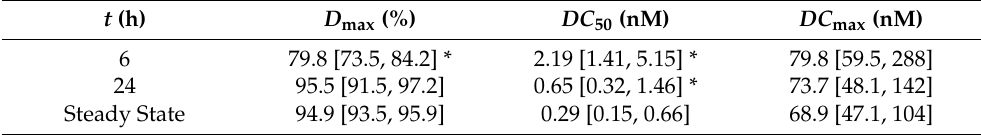
Table 1. The descriptive parameters corresponding to the two incubation times are stated together with their steady-state counterparts. Parameter values for 6 h and 24 h incubation were obtained by fitting two individual hook models (Equation (12)) to the data. Fitting the extended hook model (Equation (14)) to both time points simultaneously allows to estimate the steady-state values. Least squares estimates are reported with the upper and lower bounds of the bootstrap 95% confidence intervals given in brackets. An asterisk (*) indicates that a parameter is significantly different from its steady-state counterpart, according to Welch’s t -test. Experimental data taken from Mares et al. [23]. t